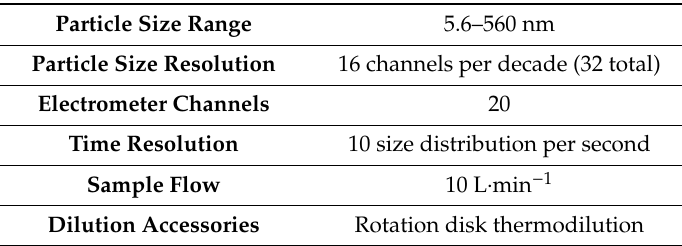
Table 3. Specification of PM analyser TSI EEPS 3090.